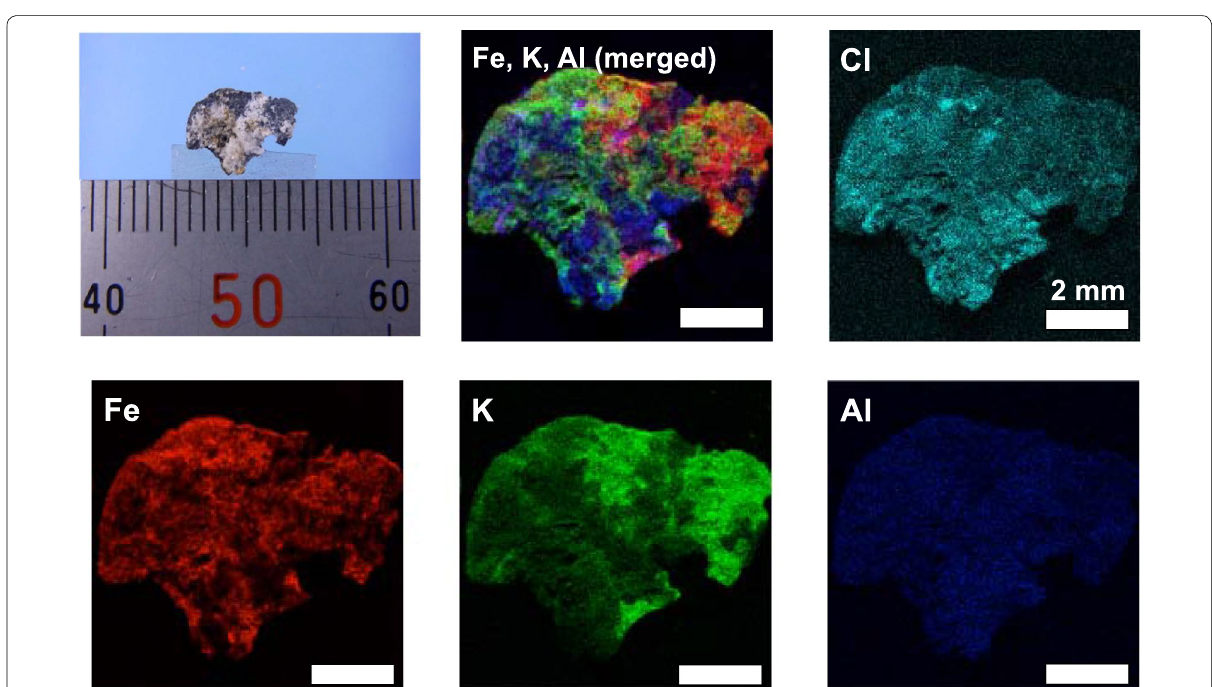
Fig. 8 μXRF surface imaging for representative elements (Fe, red; K, green; Al, blue; and Cl, light blue) for the carbonaceous products (the explosion experiment with the sabot). The white scale bar represents 2